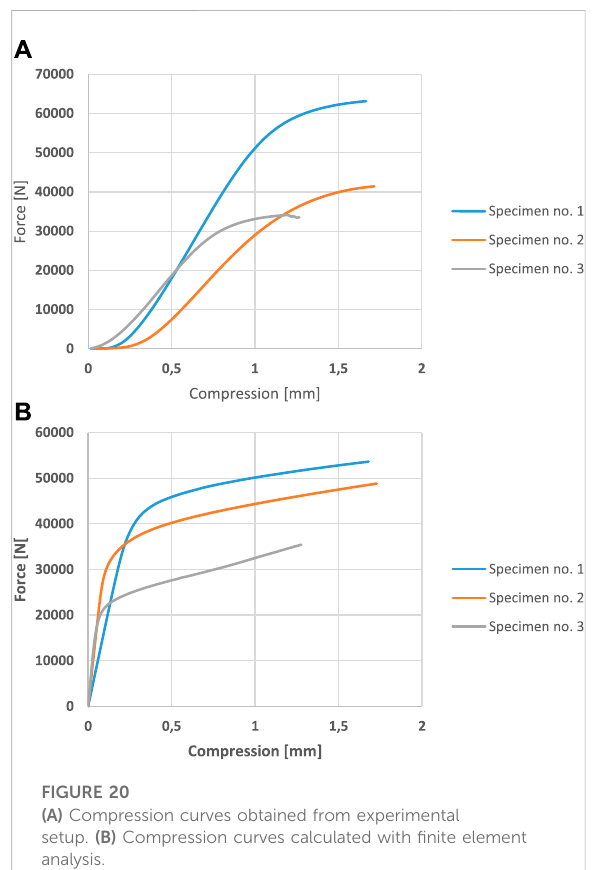
FIGURE 20 (A) Compression curves obtained from experimental setup. (B) Compression curves calculated with fi nite element